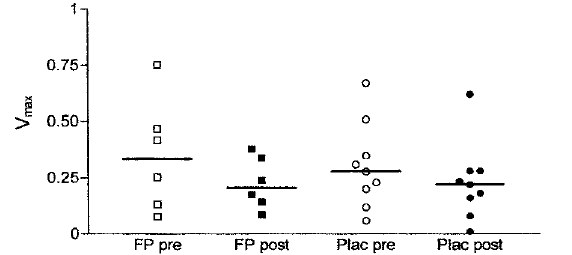
FIG. 1. Results of the superoxide production assay. V placebo; pre: pre-intervention; post: